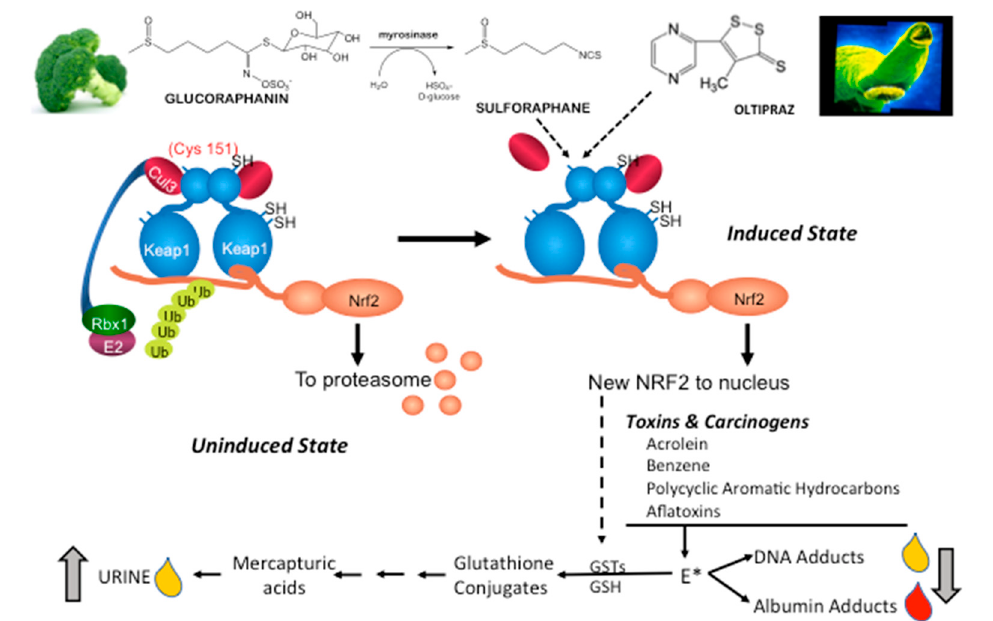
Figure 4. Induction of KEAP1-NRF2 signaling leads to enhanced detoxication of carcinogens in clinical trials. Air-borne (e.g., acrolein, benzene, polycyclic aromatic hydrocarbons) and food-borne (e.g., aflatoxins) carcinogens are metabolized to reactive electrophiles (E*) by cytochrome P450 and other enzymes. NRF2 target genes such as GSTs can conjugate glutathione (GSH) to E*, leading to formation of nonreactive, water-soluble mercapturic acids. E* can also initiate carcinogenesis by forming promutagenic DNA adducts. Some DNA adducts undergo spontaneous or enzymatic depurination allowing for excretion in urine. E* can also form protein adducts with lysine or cysteine residues in albumin. Mercapturic acids and the adducts can be quantified in clinical samples following ambient exposures using mass spectrometric techniques. Cys, cysteine; SH, sulfhydryl; Ub, ubiquitin; Cul3, cullin 3, Rbx1, ring-box 1.